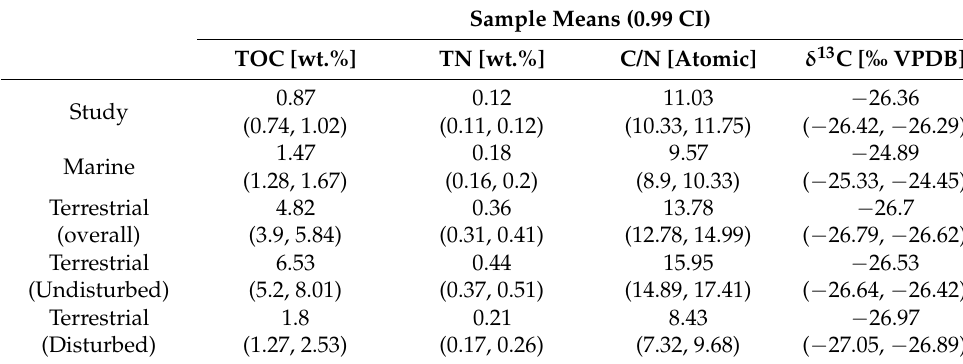
Table 1. Estimations of population means and respective 0.01 and 0.99 percentiles (in parentheses) obtained through the bootstrap analysis. Terrestrial sample values were taken from other studies (see Section 3.3), including their classification into disturbed and undisturbed. We combined these for the overall terrestrial values. Sample Means (0.99 CI) TOC